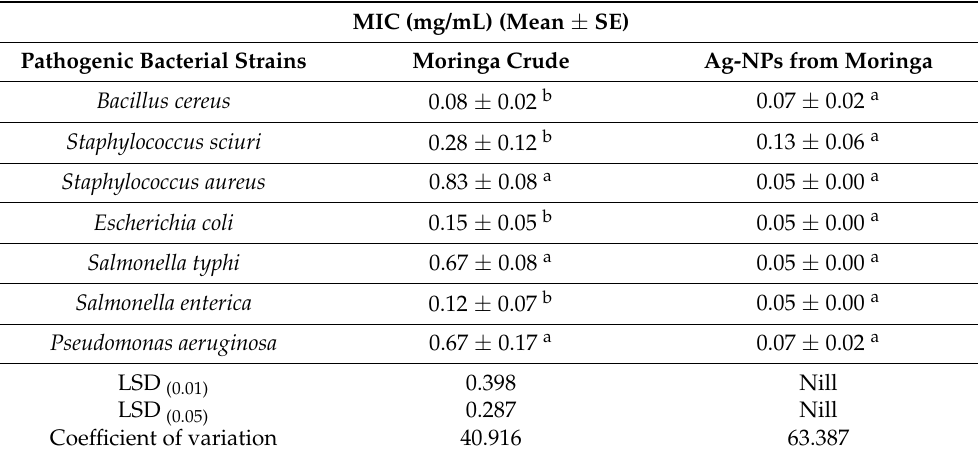
Table 10. The minimum inhibitory concentration of Moringa crude aqueous extracts and synthesized Ag-NPs against different bacterial strains.